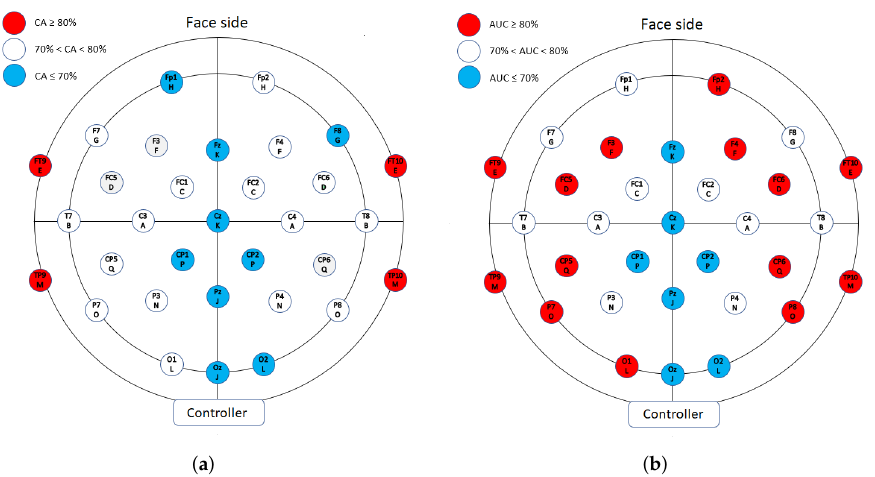
Figure 15. Electrodes with minimum (blue) and maximum (red) CA ( a ) and AUC ( b ) values in the classification (average over